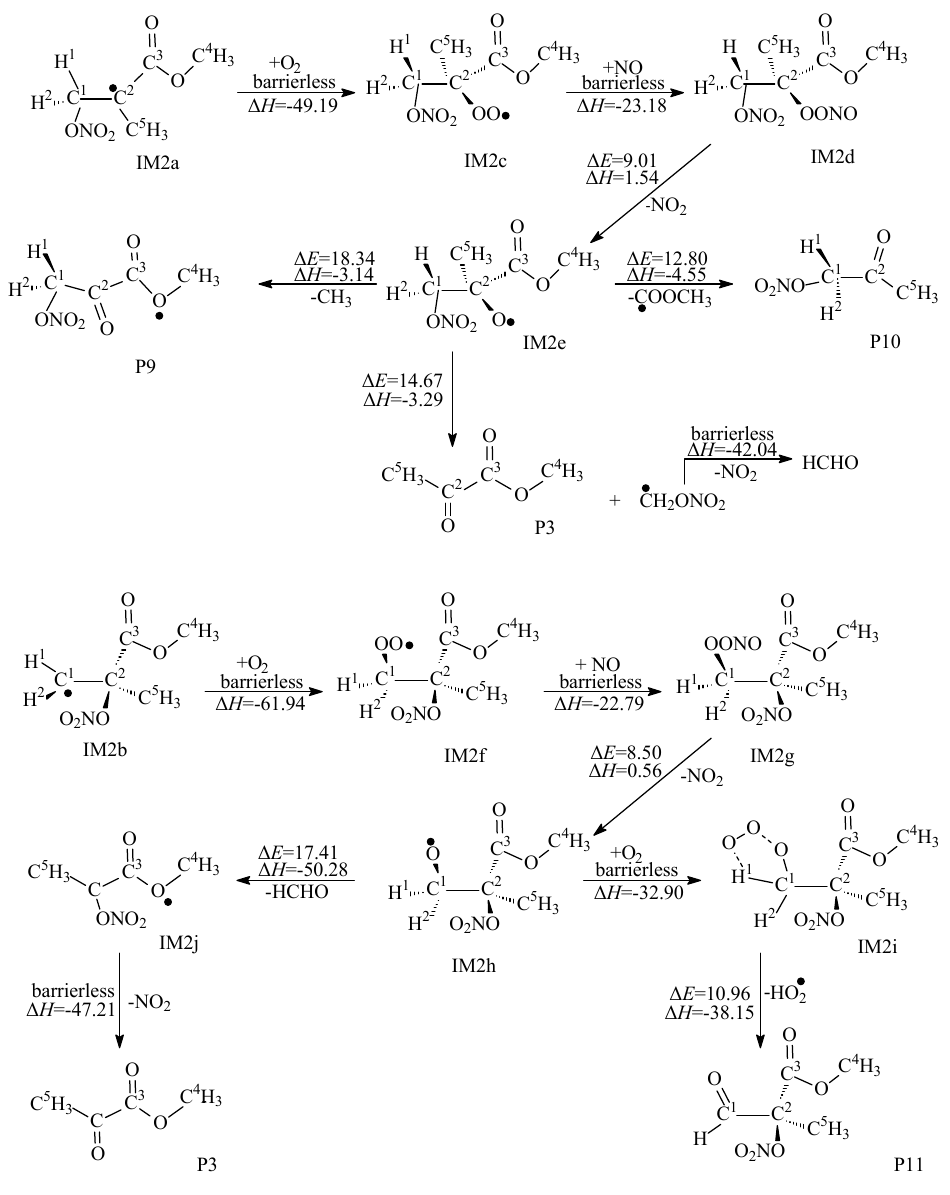
Figure 6. Secondary reaction of IM2a and IM2b. Unit: kcal/mol. Δ E : the potential barriers; Δ H : reaction heats (0